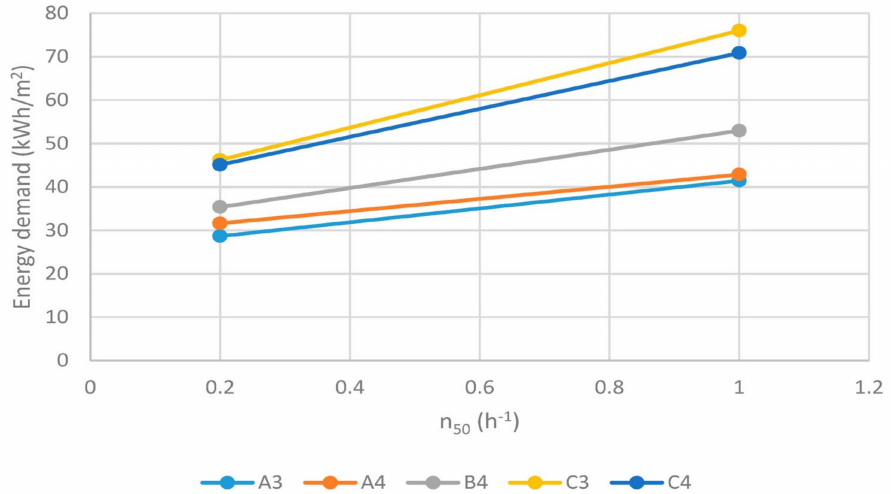
Figure 5. Dependence of the value of the annual infiltration heat loss index for an example building with different degrees of airtightness (n 50 from 0.2 to 1.0) located in different climates of Spain “most representative of Andalusia, ranging from very mild (zone A) to cold (zone C) winters and warm (zone 3) to hot (zone 4) summers”